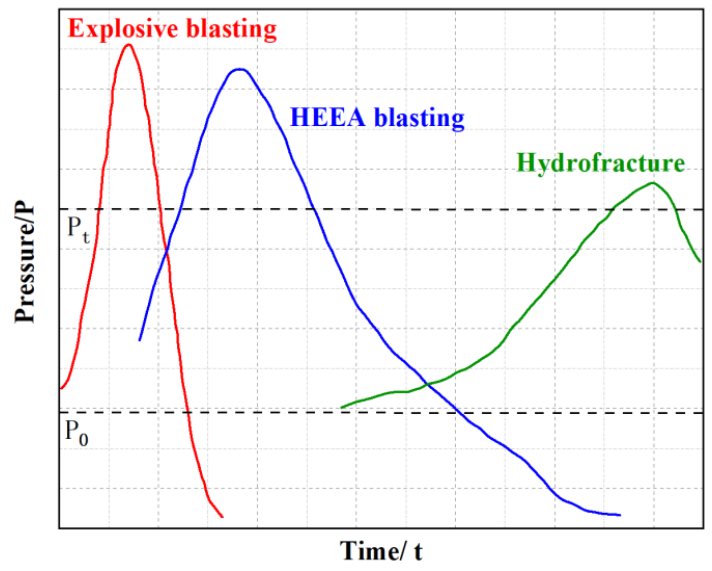
Figure 12. P- t curves of three typical fracturing forms.